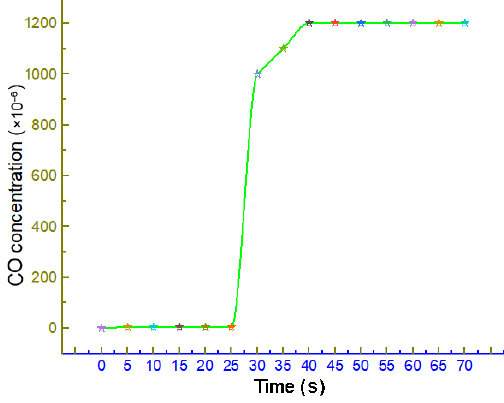
Fig. 8 Experimental result of CO concentration in